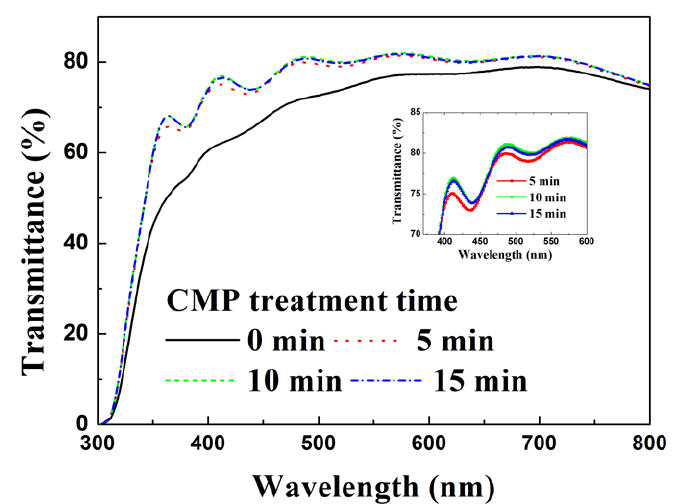
Figure 2. Optical transmittances of the fluorine-doped tin oxide (FTO) substrate as a function of CMP surface treatment time.